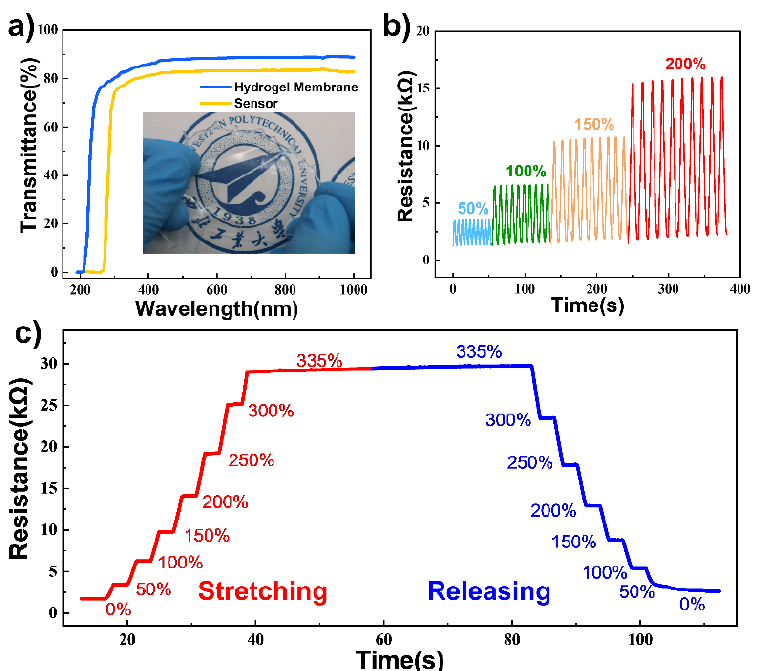
Figure 4. ( a ) Transmittances of the fabricated DN ionic hydrogel membrane and the EHTS; ( b ) Resistance variation of the hydrogel under different cyclic stretching states; ( c ) Real ‐ time response of the hydrogel resistance when stretched to 335% and then released.